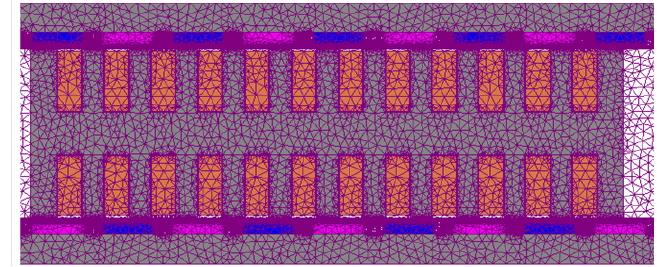
Figure 2. Structure of the 120 ◦